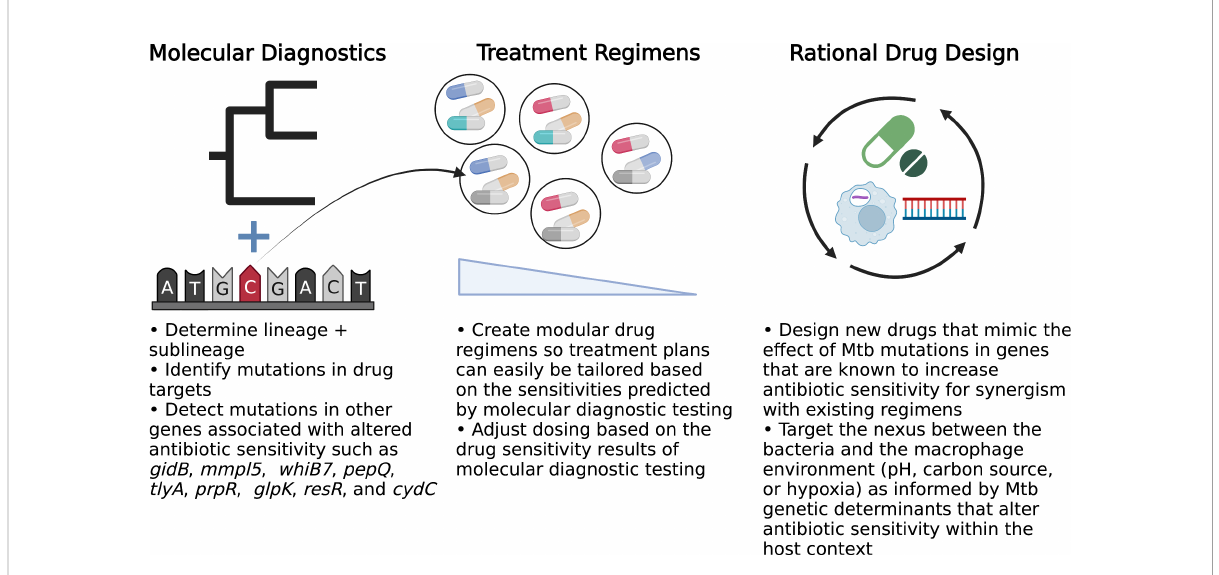
FIGURE 1 Opportunities to implement precision medicine approaches to improve TB treatment.